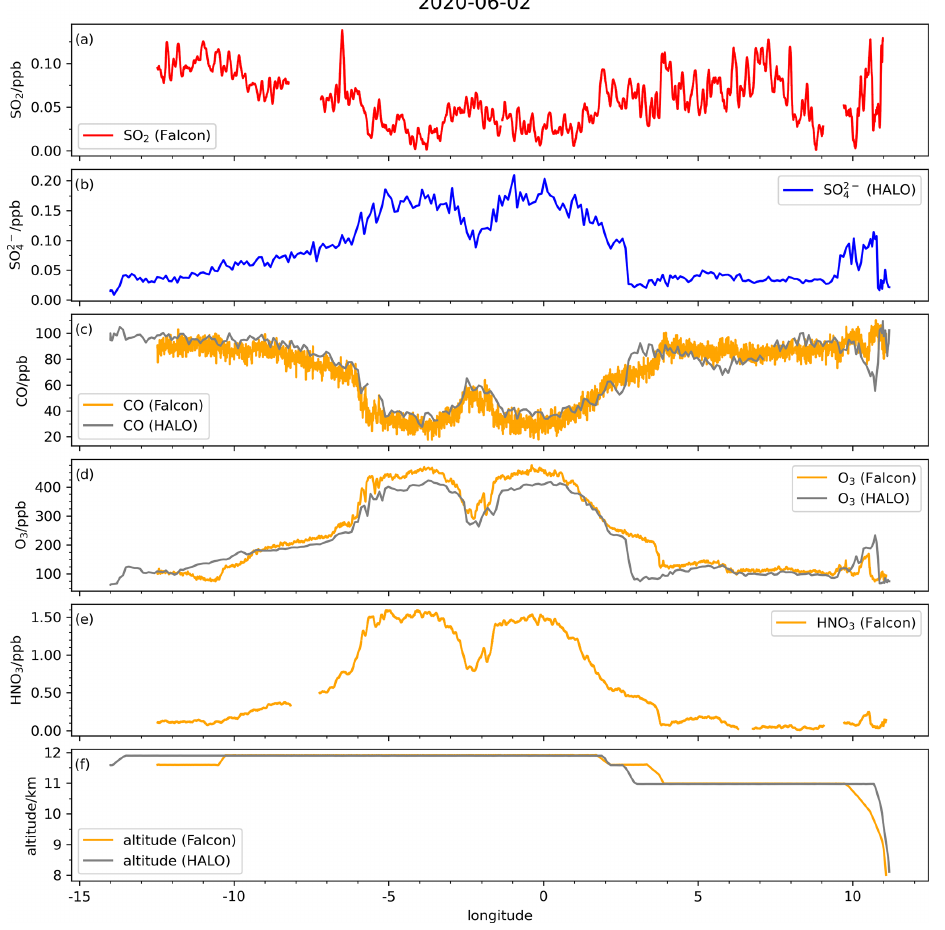
Figure 2. On 2 June 2020, HALO and Falcon had similar flight tracks from Oberpfaffenhofen towards the North Atlantic, west of Ireland. The sampling was roughly between 07:00–10:00UTC. Plotted are (a) SO 2 , (b) SO 2 − longitudes 15 ◦ W–12 ◦